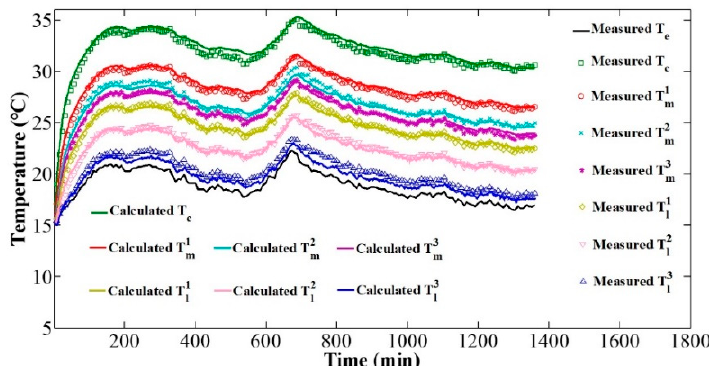
Figure 5. Temperature variation of the measured and calculated results over time.